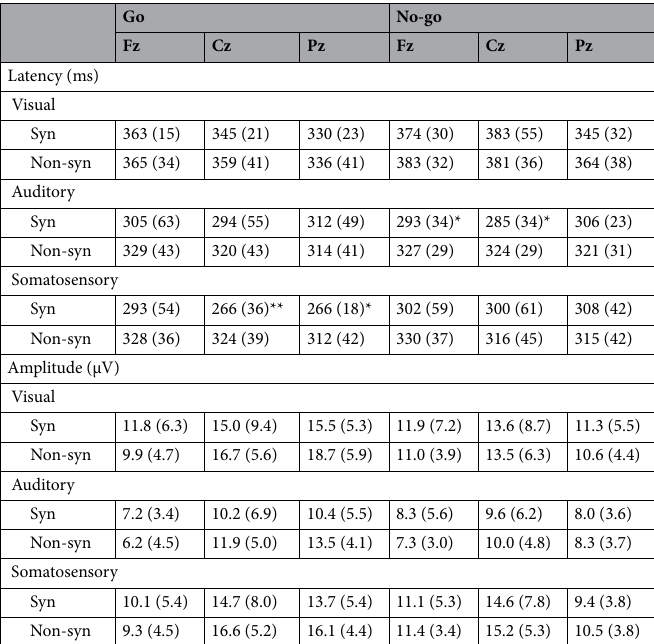
Table 4. Mean values for the latency and amplitude of P3 component in synesthete and non-synesthete groups with SD. ANOVA and Mann–Whitney test showed significant differences between groups as *p < 0.05 and **p <